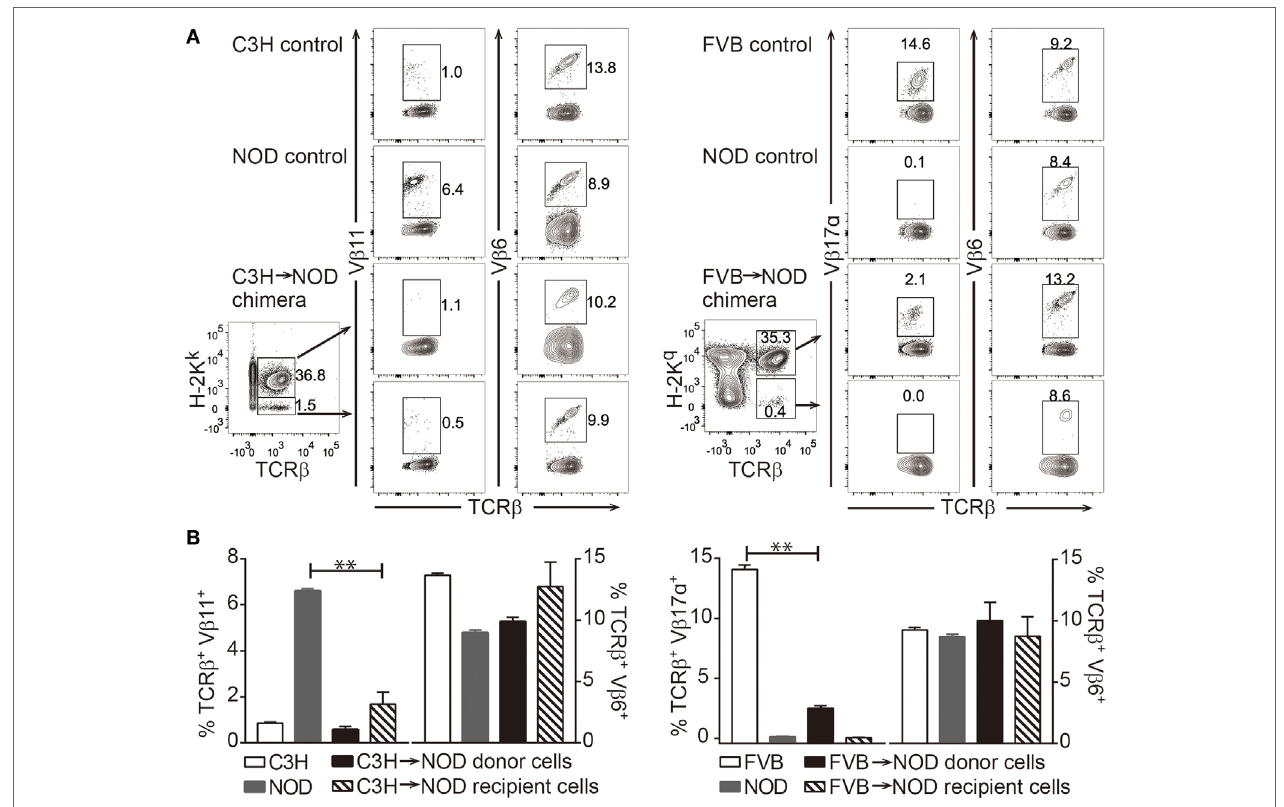
FigUre 5 | Clonal deletion of alloreactive T cells in chimeras. (a,B) Frequencies of recipient anti-donor (V β 11 + ) T cells in C3H → non-obese diabetic (NOD) chimeras and donor antirecipient (V β 17 α + ) T cells in FVB → NOD chimeras were evaluated at 8–12 weeks postbone marrow transplantation. (a) Shown is the gating strategy. (B) Shown are the frequencies of V β 11 + , V β 6 + , and V β 17 α + T cells in the peripheral blood lymphocytes. Values are shown as the mean ± SEM. Numbers of animals used for analysis in the left panel: naive C3H n = 6, naive NOD n = 7, C3H → NOD chimeras n = 4; right panel: naive FVB n = 4, naive NOD n = 4, FVB → NOD chimeras n = 8. ** p < 0.005, Student’s t -test with Welch’s correction when variances were significantly